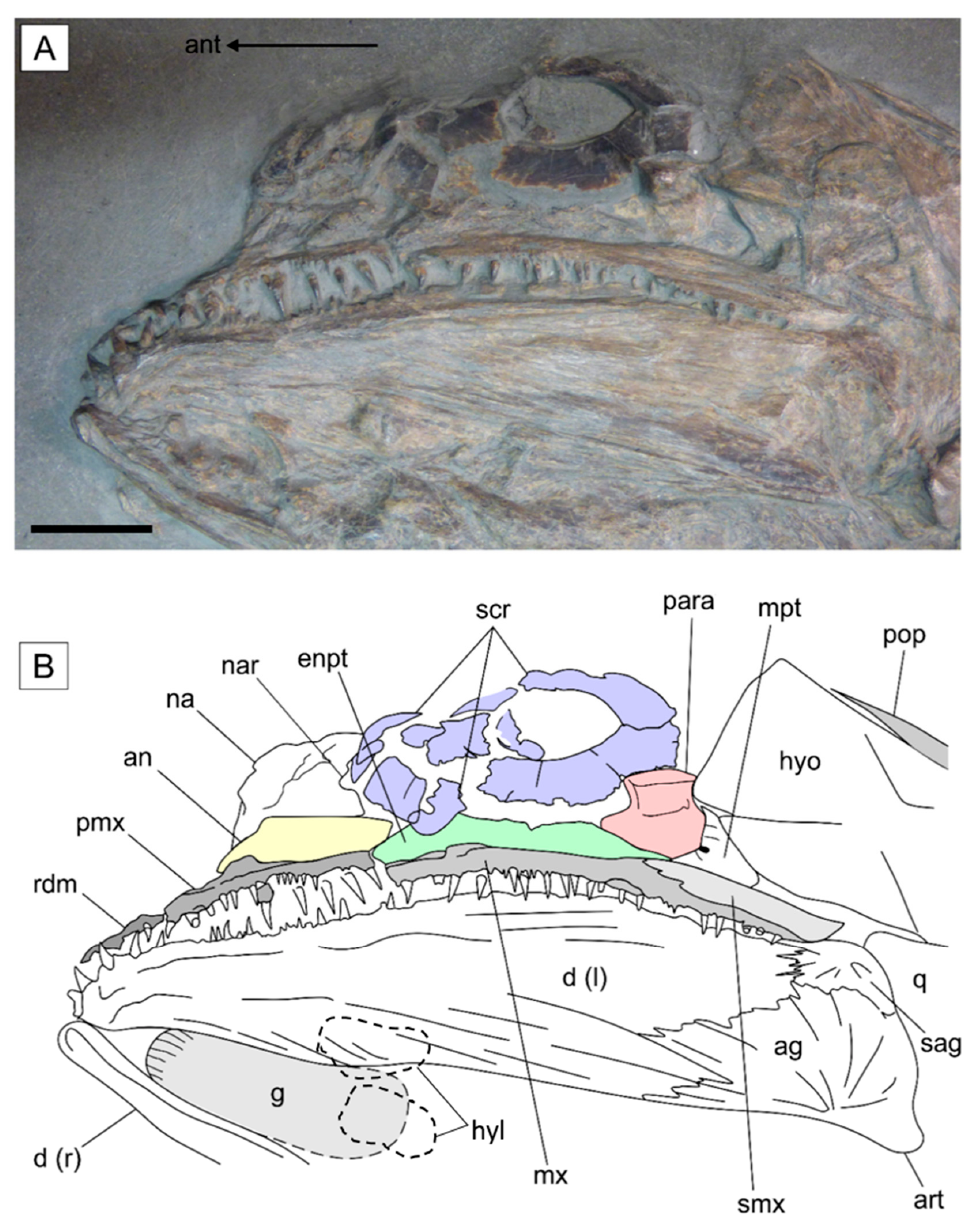
Figure 4. Jaws and orbital region of Germanostomus pectopteri gen. et sp. nov.: ( A ) photograph of the holotype SMNS 15815 in left lateral view; ( B ) interpretive line drawing with false color added to help differentiate bone boundaries. ag, angular; an, antorbital; art, articular; d, dentary (l, left; r, right); enpt, endopterygoid; g, gular; hyl, hypohyals; hyo, hyomandibula; mpt, metapterygoid; mx, maxilla; na, nasal; para, posterior region of the parasphenoid; pop, preopercle; pmx, premaxilla; q, quadrate; rdm, rostrodermethmoid; sag, surangular; scr, sclerotic ring; smx, supramaxilla. Scale bar = 20 mm.